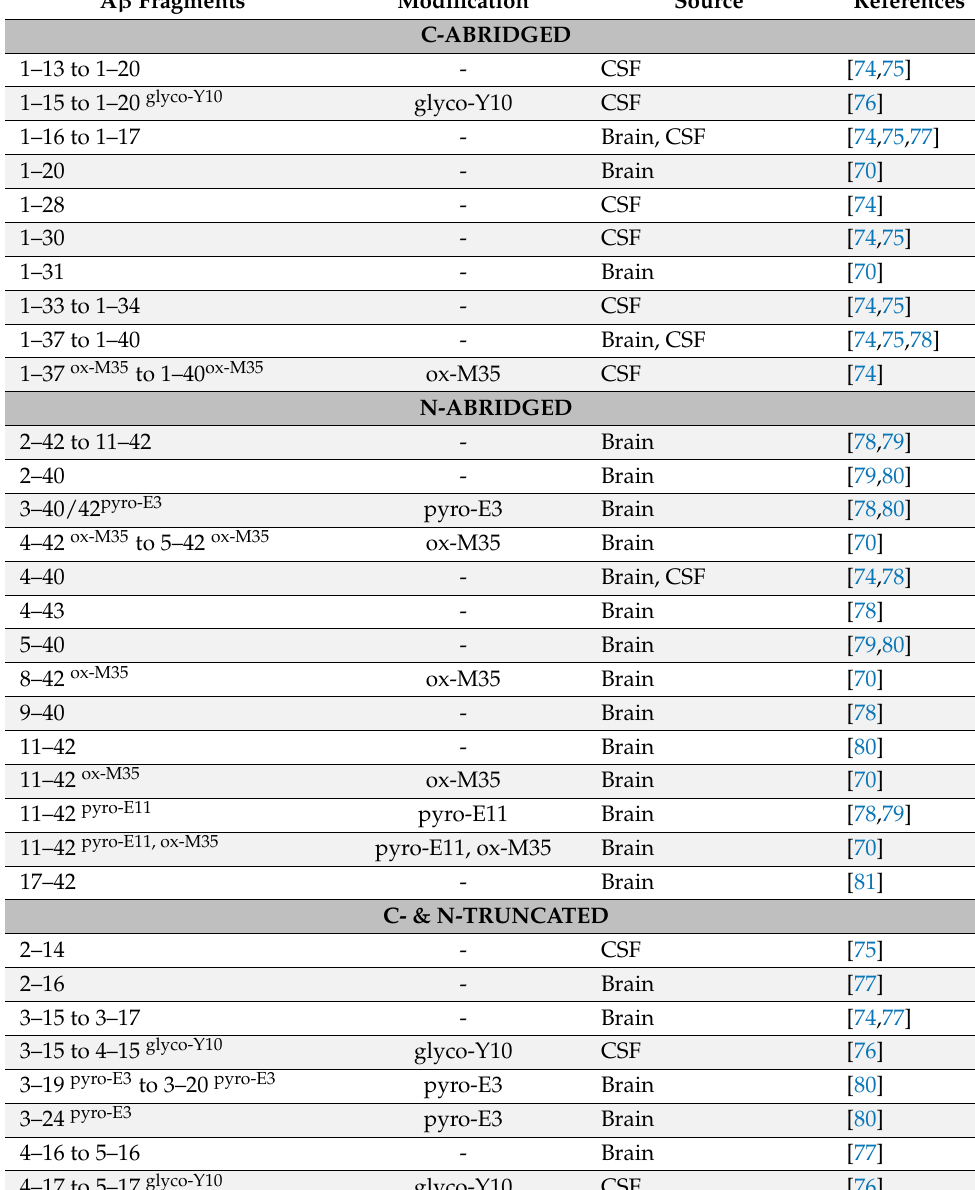
Table 1. Overview of abridged and/or modified A β -species detected in the brain or CSF of AD patients. Superscript description indicates modification at the respective amino acid (glyco-Y10 = glycosylation at tyrosine at position 10 of the A β -domain sequence, ox-M35 = oxidation at methionine at position 35, pyro-E3/11 = pyroglutamylation at glutamate at position 5 or 11, race-D-S26 = racemization of D-conformation serine at position 26). A β